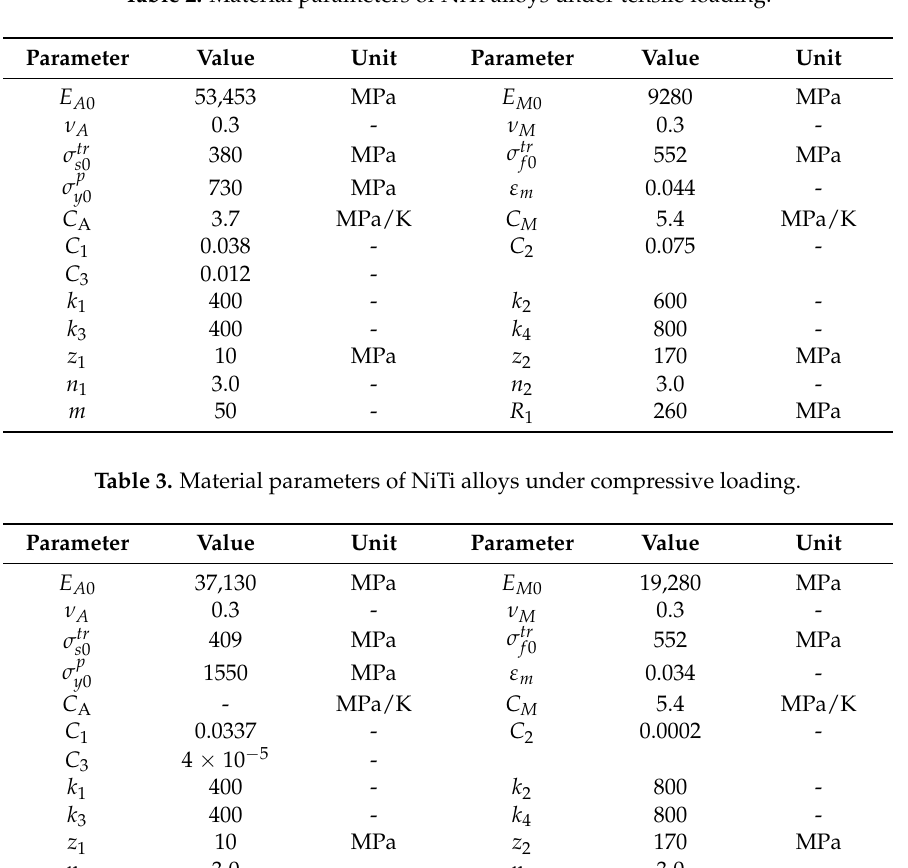
Table 2. Material parameters of NiTi alloys under tensile loading.